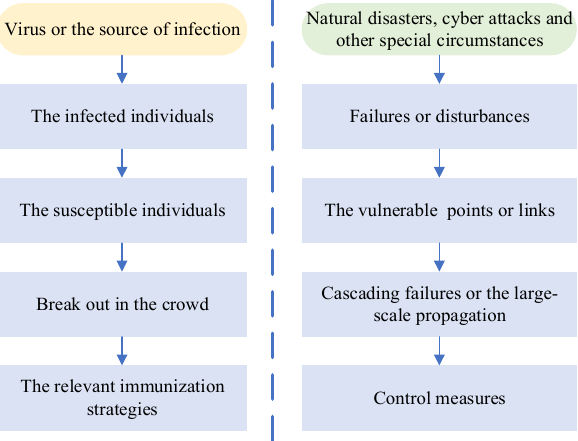
Figure 1. Analogy between epidemic spread and failure propagation in power systems.